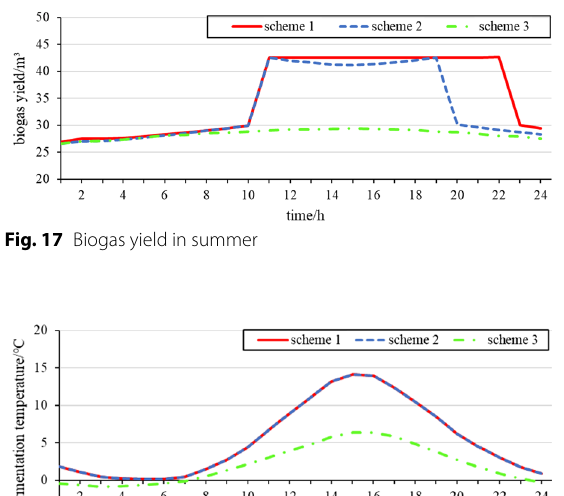
Table 2 Comparative results of schemes 1–3 on typical summer